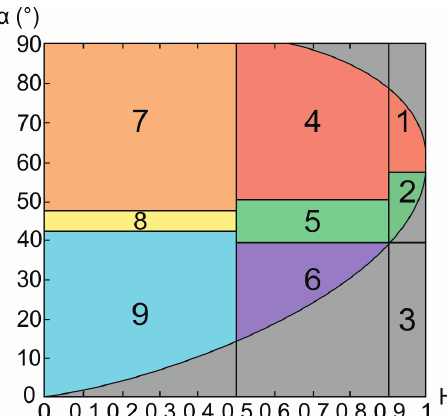
Figure 4. H/ α segmentation plane (modified after [20]). The numbers represent different types of backscattering as described in the text. The oil well pads—characterized as areas free of vegetation—are located within segment “9”. The grey colored area including “3” is not